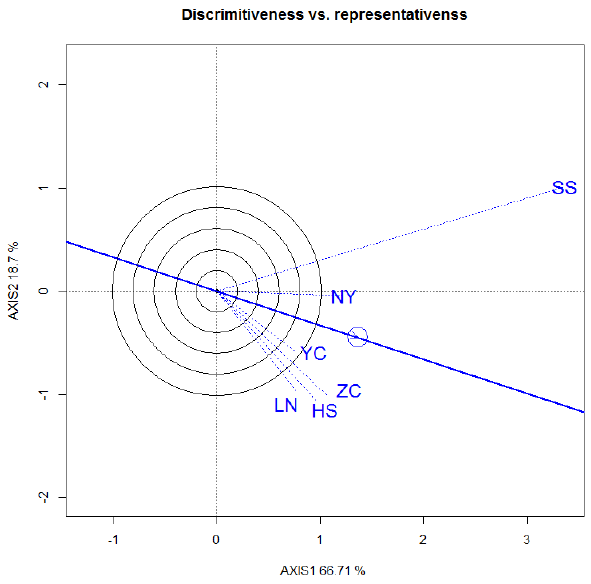
Figure 8. Discrimitiveness and representativeness of DBH of 6 sites. Figure 8. Discrimitiveness and representativeness of tree height of 6 sites.